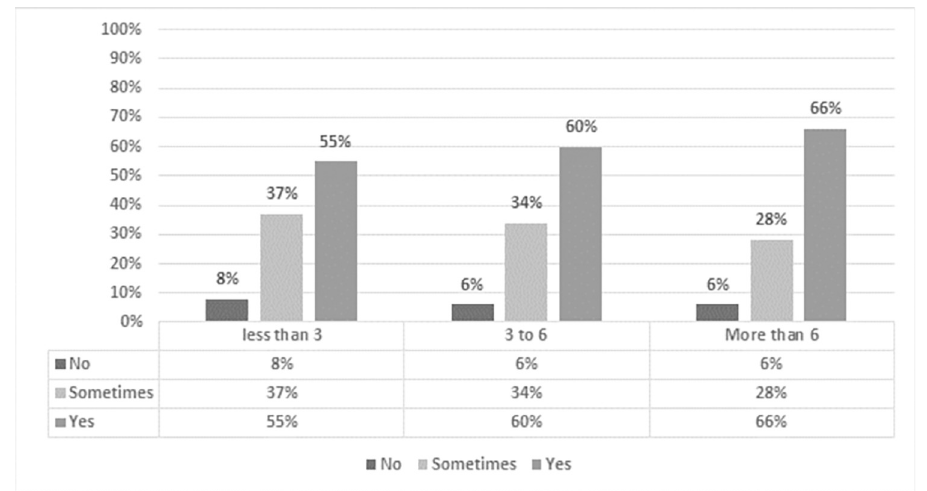
Fig 3. Number of online working hours and frequency of facing mental